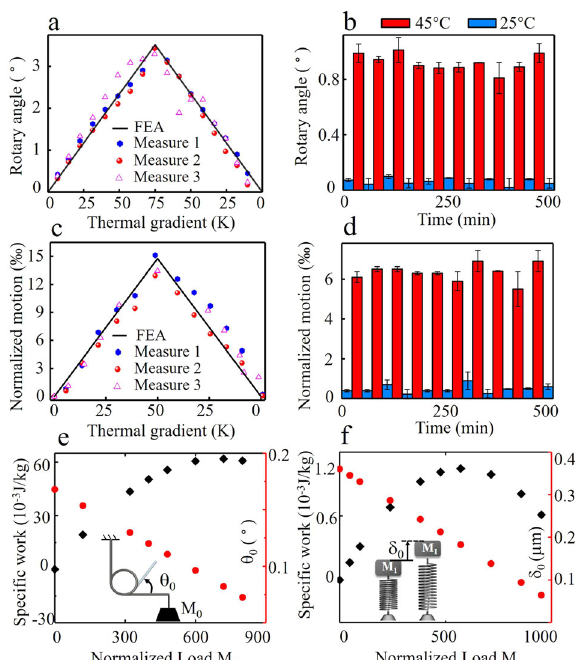
Fig. 4 Temperature-dependent measurement of the fabricated stacks. a , c Dependence of motional amplitudes of the stacks with the thermal gradient for rotation and translation, respectively. The plots show a symmetric, linear, and reversible amplitude response. b , d Cyclic stability of the structures for rotation and translation, respectively, where temperatures are switched between 25 °C (marked in blue) and 45 °C (marked in red). The error bars (marked in black) indicate the difference between experimental and numerical results. Note that the translational displacements in panels ( c – d ) are normalized to the initial non-heated stack length in the z -direction. e , f The speci fi c work (i.e., the work normalized to the mass of the structure) and the actuation motion of the elements under thermal stimuli are plotted versus the normalized load and represented in analogy with Hooke ’ s springs shown in the insets. Loads M 0 and M 1 have been normalized by the mass of the rotational element (2.5 × 10 − 10 kg) and translational element (2.1 × 10 − 10 kg), respectively. A linear relationship between displacements and external loads is observed in both cases, suggesting that the elastic limit is not the absence of active cooling. When external heating is released, motion gradually decreases until the initial rest point is retrieved.